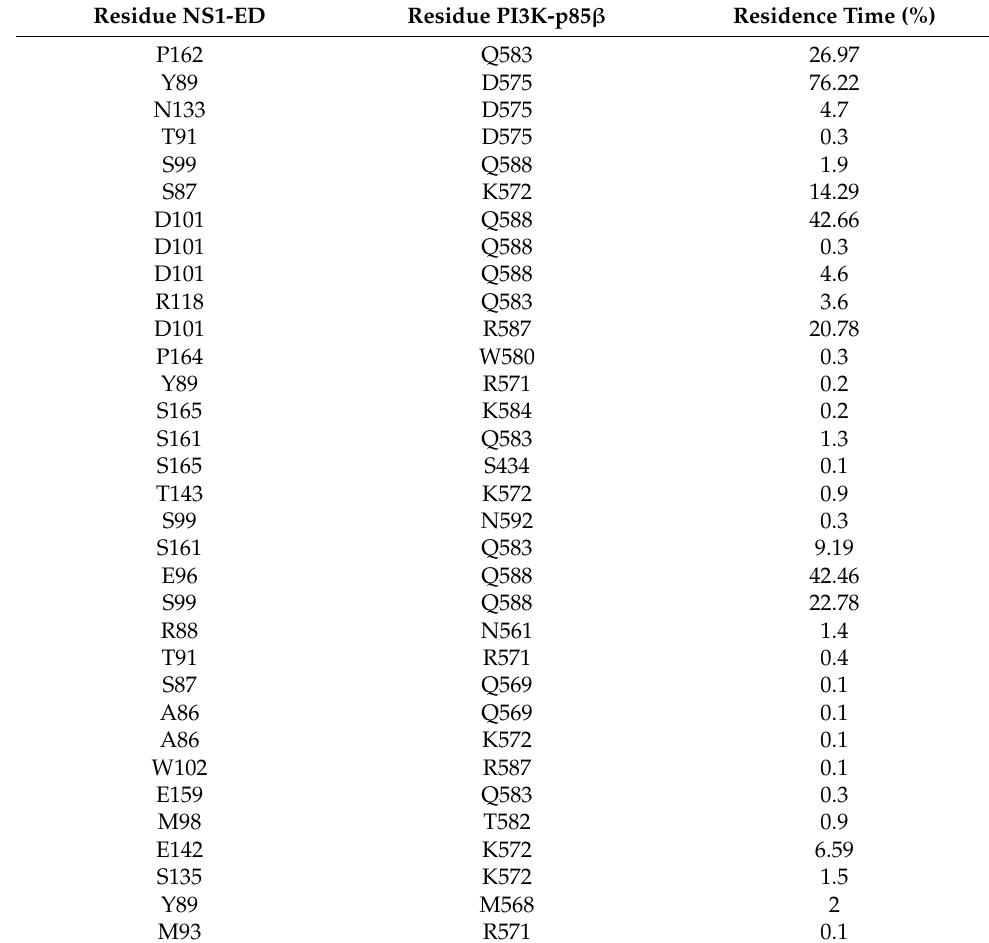
Table 8. Hydrogen bonds formed at the interface of the NS1-PI3K